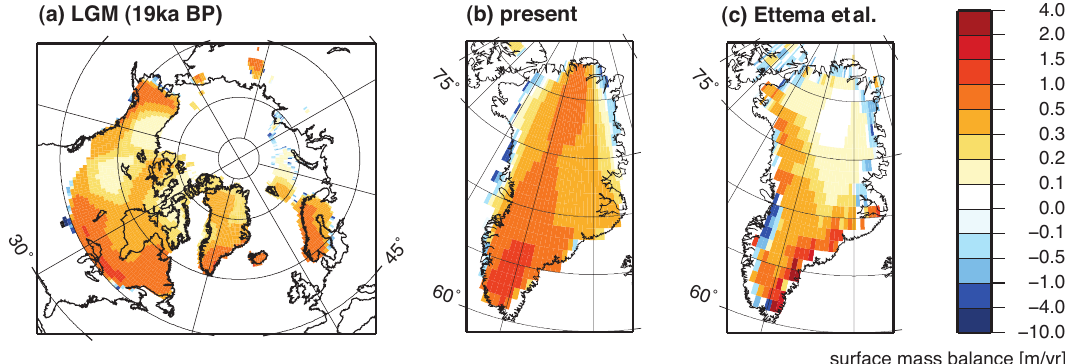
Figure 4. Surface mass balance (a) in CTR at LGM (19kaBP), (b) in CTR at present, and (c) interpolated onto the IcIES grid from a Fig. 4. Surface mass balance a, in CTR at LGM (19 ka BP), b, in CTR at present, and c, interpolated onto the IcIES grid from a high-resolution high-resolution model simulation by Ettema et al. model simulation by Ettema et al. (2009).